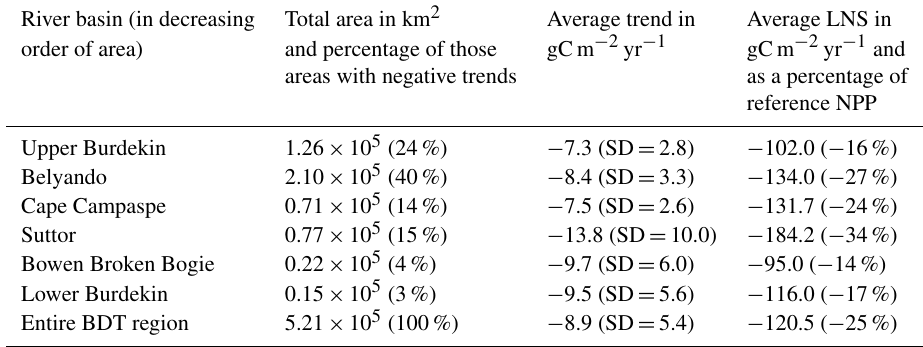
Table 6. Negative trends in area, interannual rate, and severity of LNS for river basins of the Burdekin Dry Tropics. SD – standard deviation.